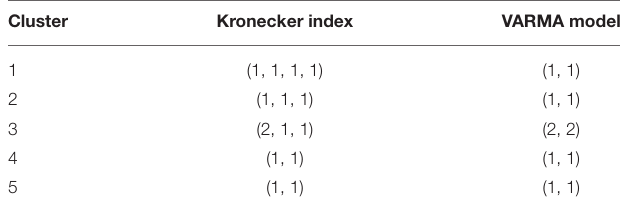
TABLE 1 | The best vector autoregressive moving average (VARMA) model for each cluster. Cluster Kronecker index VARMA